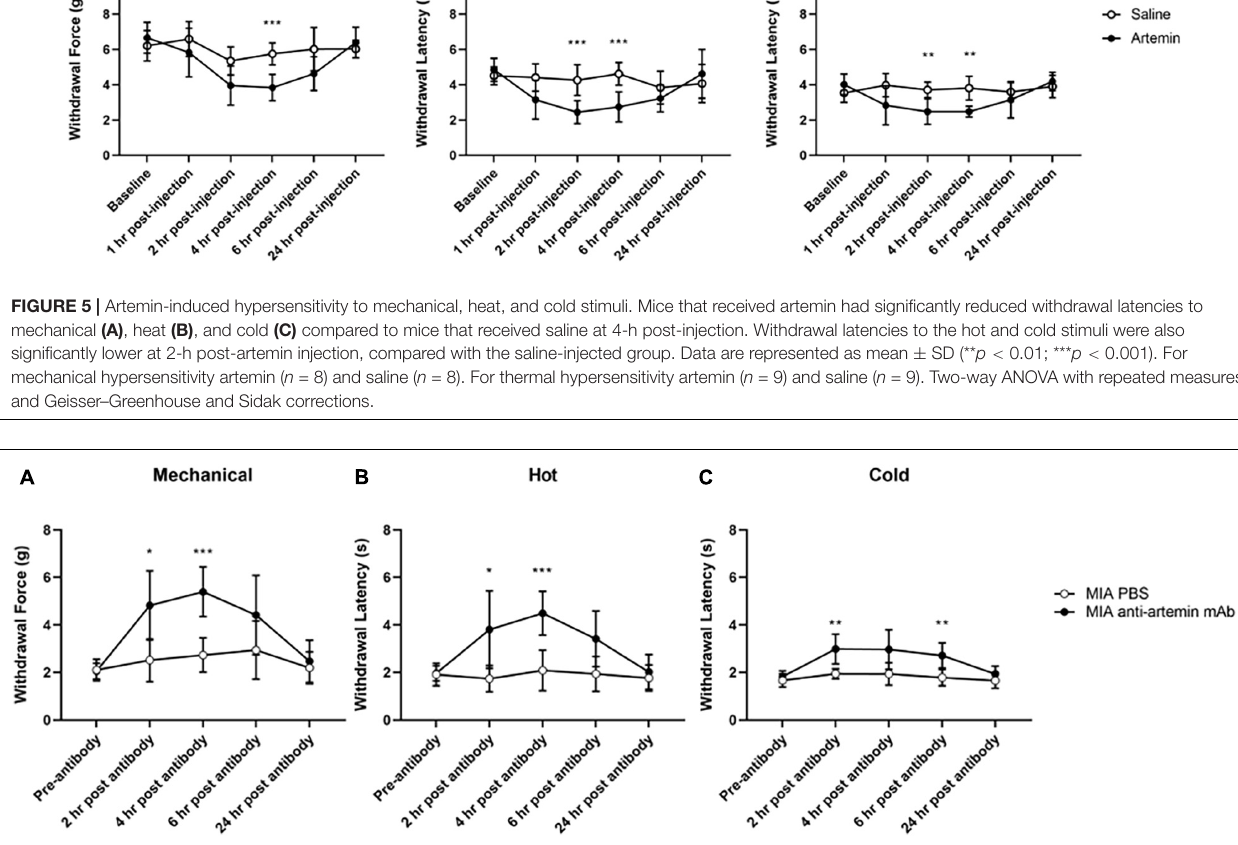
FIGURE 6 | An anti-artemin antibody alleviates hyperalgesia in the MIA-induced mouse model of OA-pain. A systemic anti-artemin monoclonal antibody alleviates MIA-associated hypersensitivity for mechanical (A) , heat (B) , and cold (C) . Anti-artemin mAb was effective in reversing mechanical and heat hypersensitivity at 2- and 4-h after antibody. Anti-artemin mAb reversed cold hypersensitivity at 2 and 4 h post-mAb injection, compared with PBS injected MIA controls. MIA anti-artemin mAb ( n = 8) and MIA PBS ( n = 7). Data are represented as mean ± SD (* p < 0.05; ** p < 0.01; *** p < 0.001). Two-way ANOVA with repeated measures and Geisser–Greenhouse and Sidak